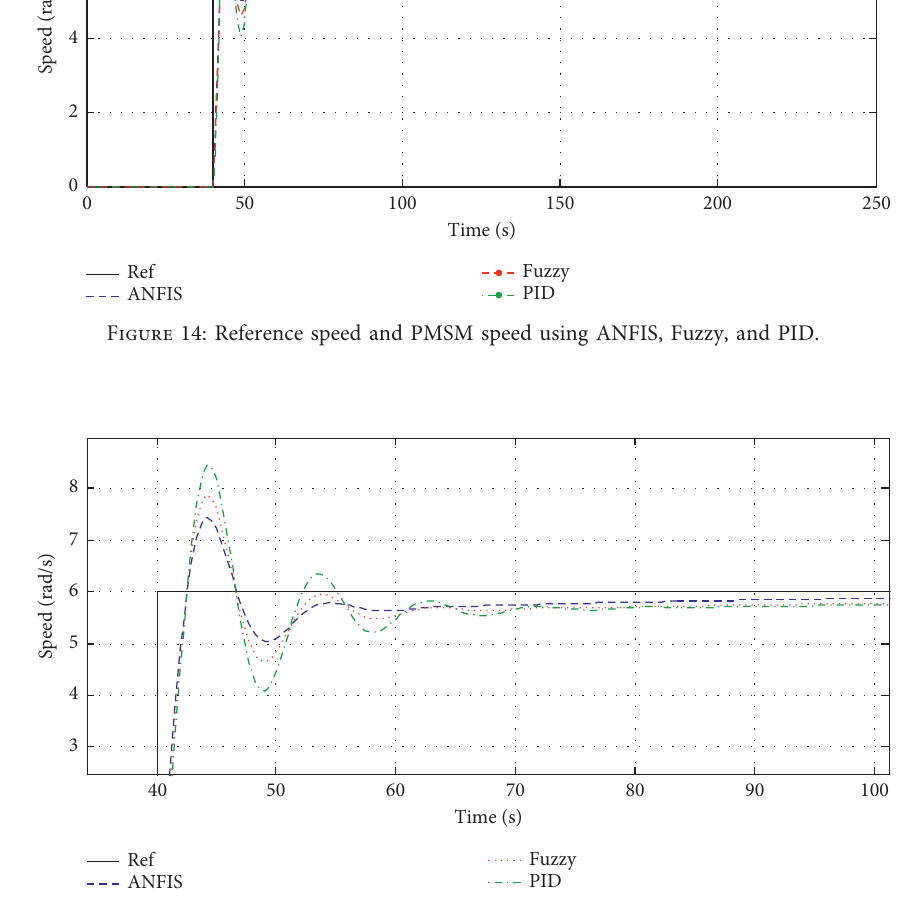
Figure 15: A magnification of the transient part of Figure 14.